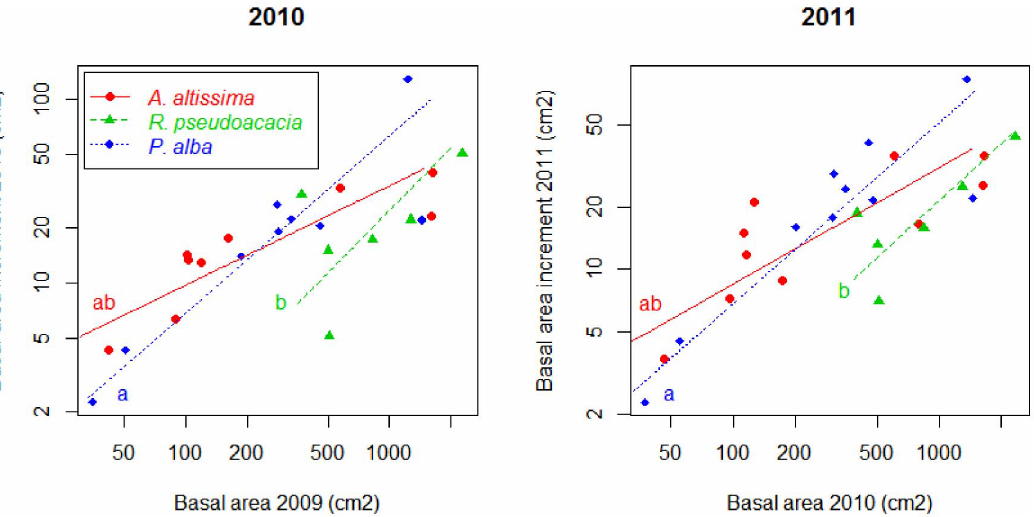
Figure 4. Tree basal area increment. Allometric relationship between current-year basal area increment and previous-year basal area for 2010 (left) and 2011 (right). Each dot corresponds to a different tree. Different letters indicate significant difference of elevation across species (pairwise Wald test for multiple comparison, P , 0.017, after Bonferroni correction). Slopes did not significantly differ across species (see Table 4).